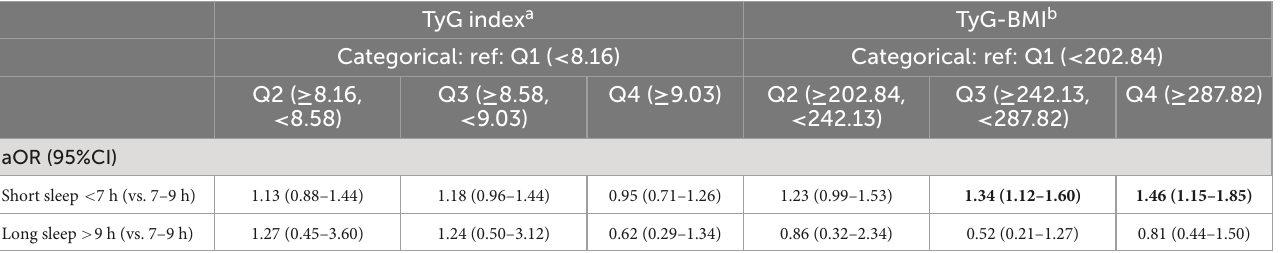
TABLE 5 Associations between TyG, TyG-BMI, short sleep and long sleep duration. TyG index a TyG-BMI